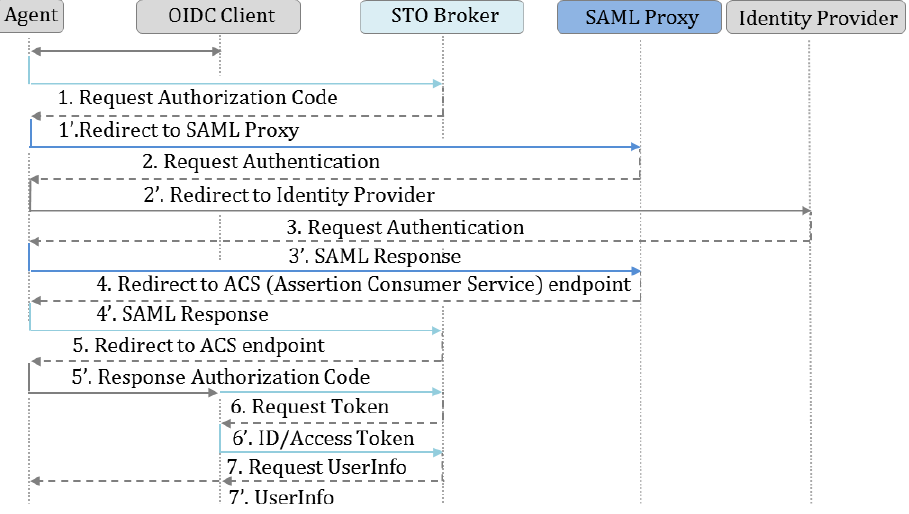
Figure 2. Authentication message flows.